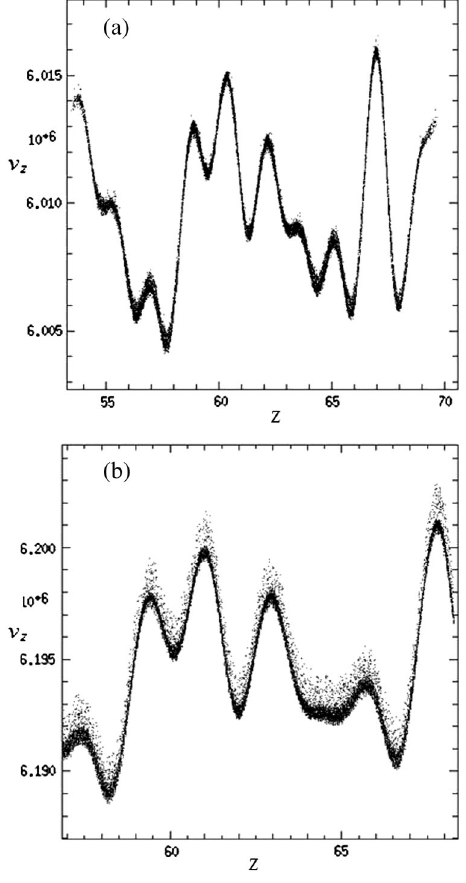
(cid:1) z phase space after (a) 70 gaps; (b) 75 z